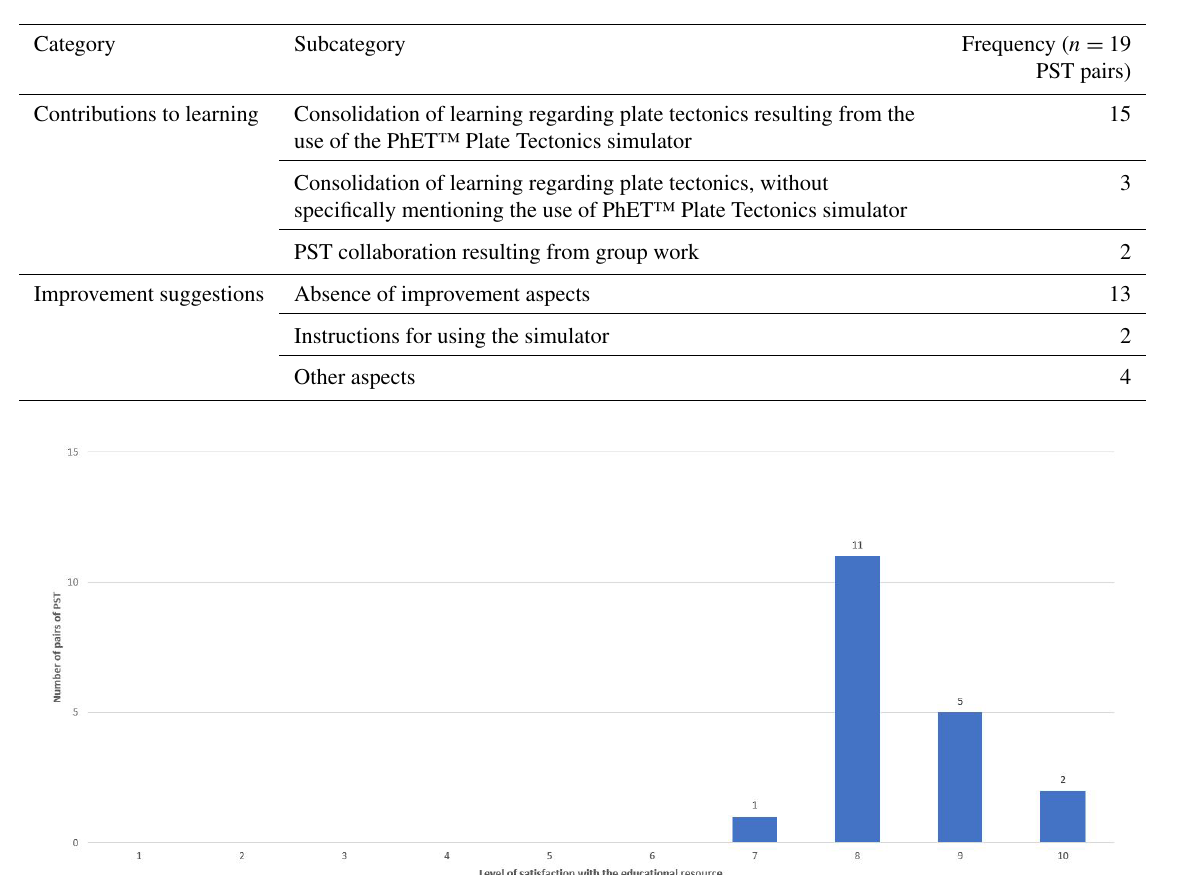
Table 5. Categorization of the answers from PSTs regarding the contributions of the educational resource to their learning and suggestions for improvement.